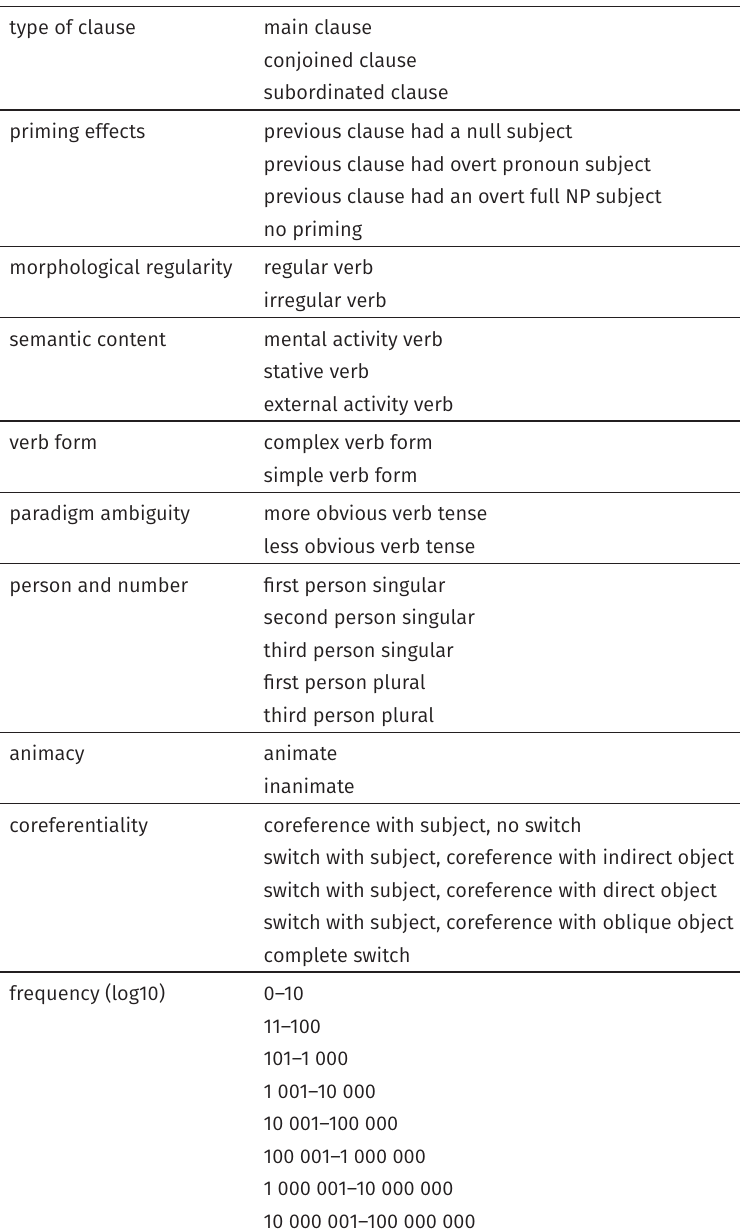
Table 7: Independent linguistic factors for coding